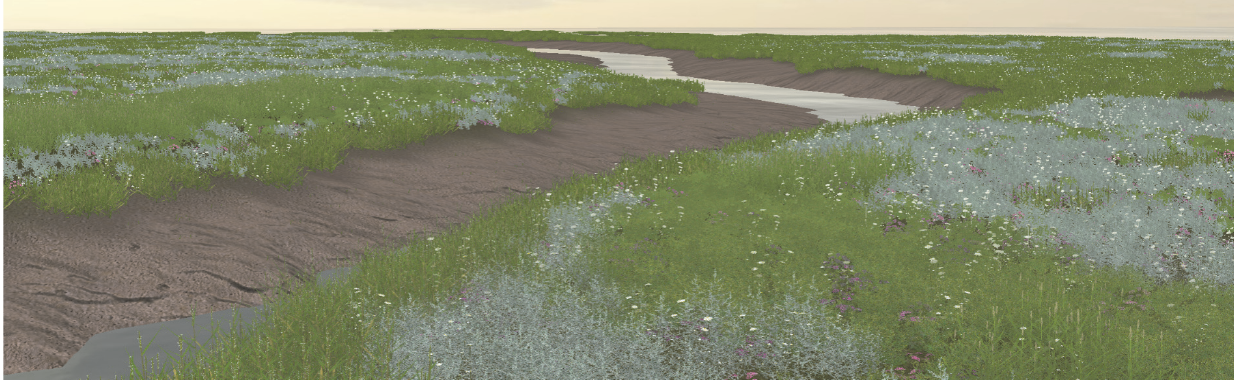
Figure 1: Virtual Paulinapolder: a salt marsh located in the Netherlands, generated, and rendered with our framework.